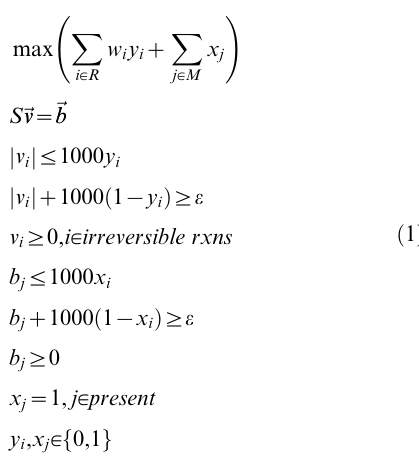
genome-scale metabolic models for normal tissues together with 16 for cancer tissues. A dendrogram generated by unsupervised hierarchical clustering of the models based on predicted gene presence and absence is shown. Figure S2 The relative pathway enrichment profiles, based on KEGG pathways, for each of the models. Blue corresponds to underrepresentation and red to overrepresentation.